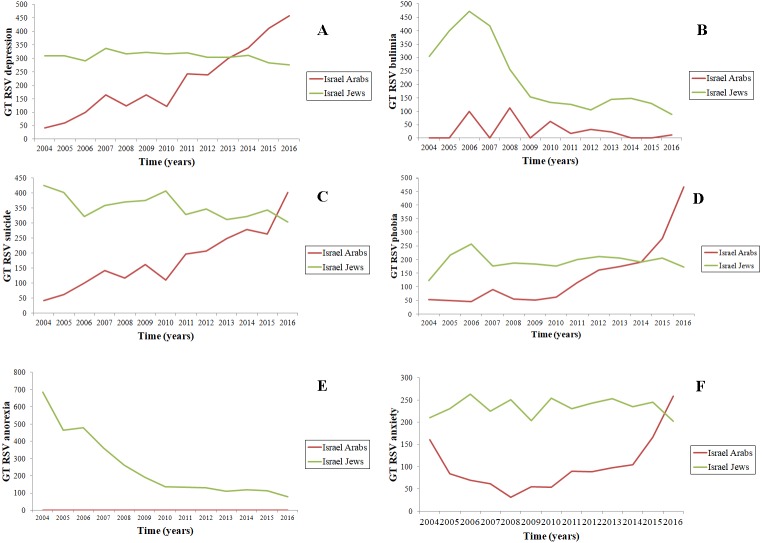
Plots showing the trends of web searches related to psychiatric disorders (namely, (A) depression, (B) bulimia, (C) suicide, (D) phobia, (E) anorexia and (F) anxiety) as captured by Google Trends (GT).